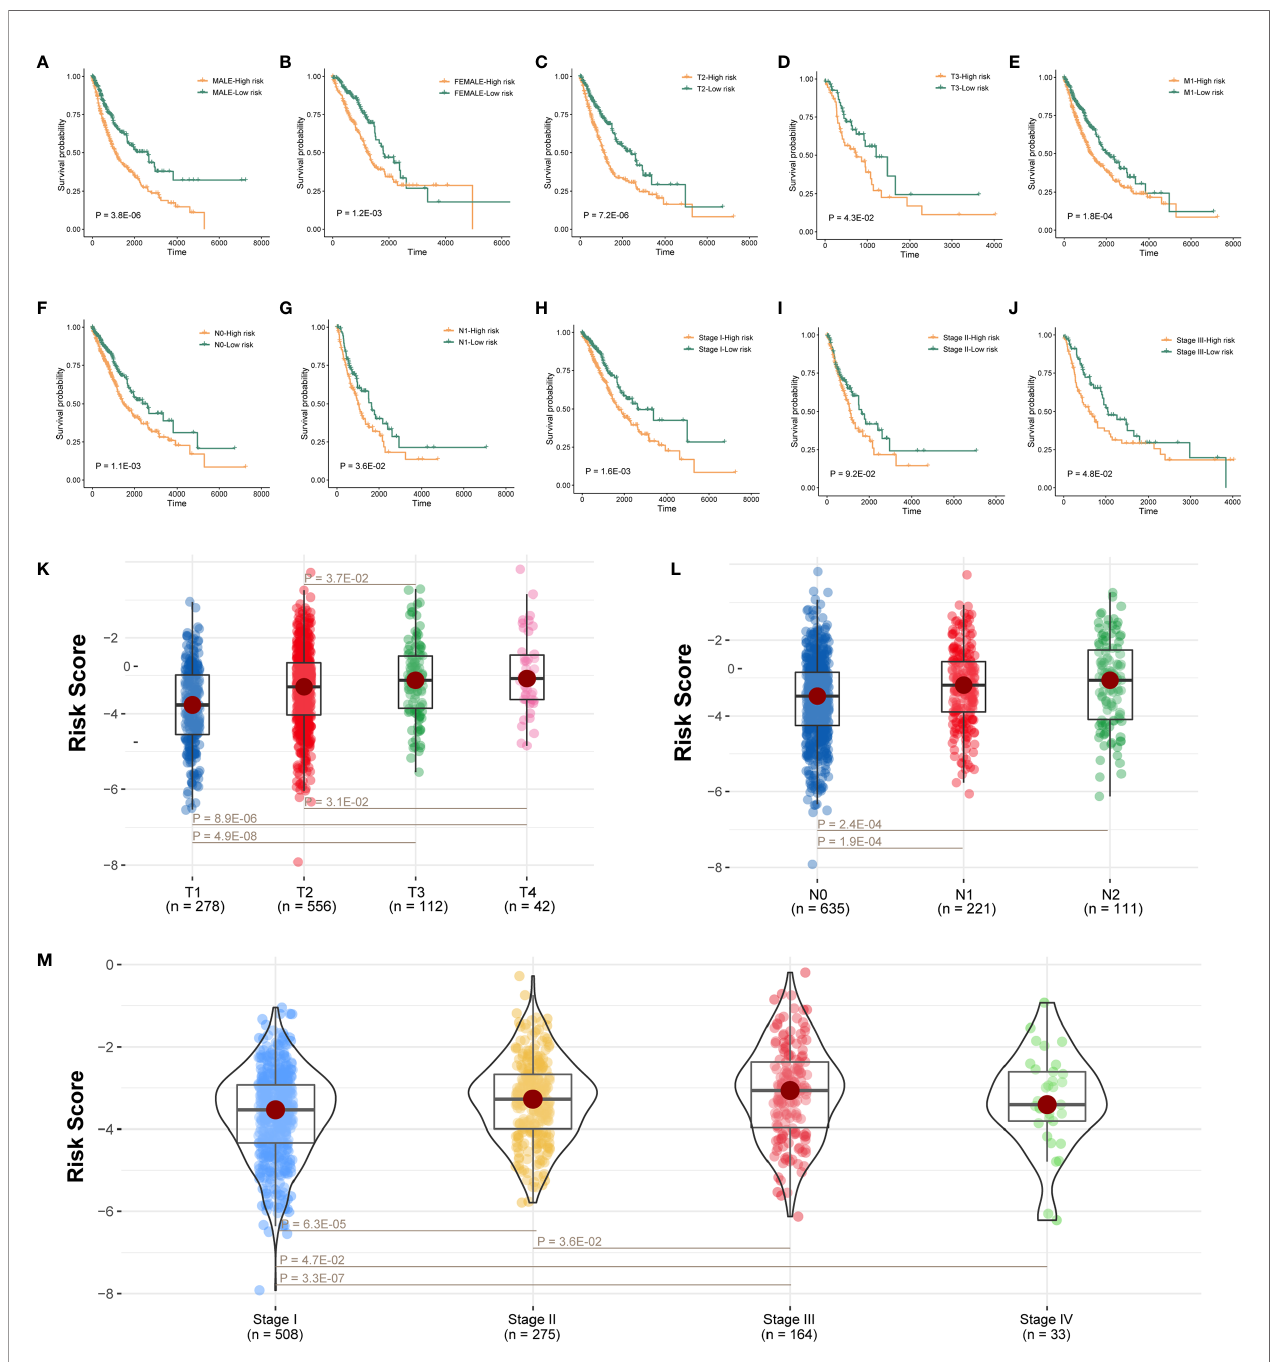
FIGURE 4 | Prognostic model connected with clinical pathological features. (A – J) Survival analysis of sexual groups, T stage (T2 and T3) groups, M3 stage group, N stage (N0 and N1) groups, or clinical stage (stage I, stage II, and stage III) groups in TCGA lung cancer cohort. (K – M) Wilcoxon rank-sum test showed the risk differences between T stage groups, M stage groups, or clinical stage in TCGA lung cancer